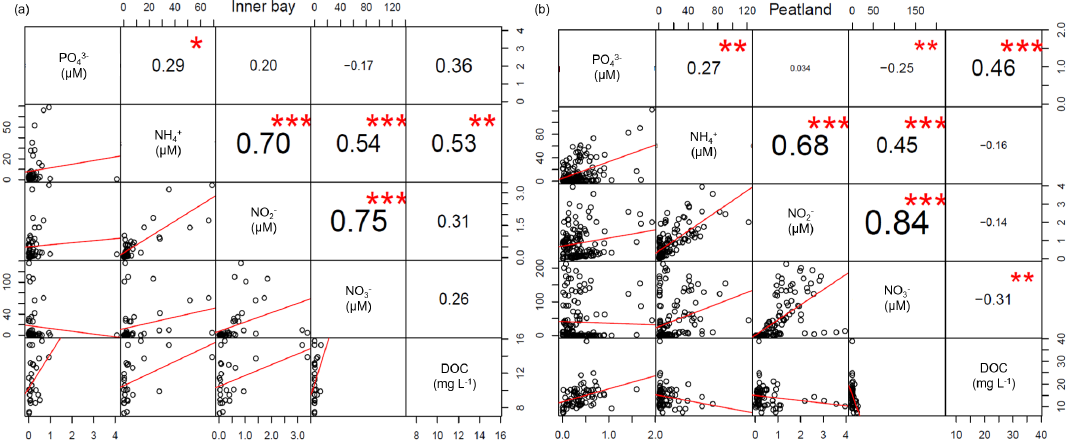
Figure D1. Cross-plots of the measured nutrients (NH + land across all seasons. Significant correlations are indicated by